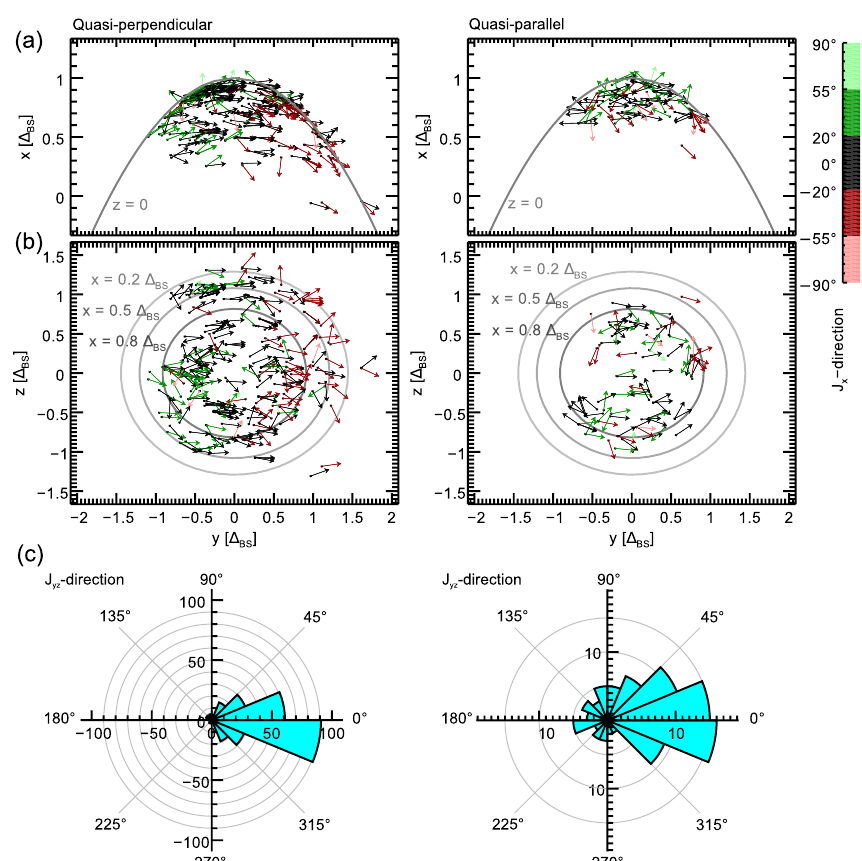
Figure 6. Bow shock current directions in the x − y plane (a) and y − z plane (b) . J x direction is represented by the colour code. The z axis of the coordinate system is aligned to the IMF yz component. The grey paraboloid and ellipsoids represent the bow shock position at z = 0 and x = 0 . 2 , 0 . 5, and 0 . 8 (cid:49) BS , respectively. Polar histograms (c) show the occurrence rates of current angles within the y − z plane with respect to the positive y